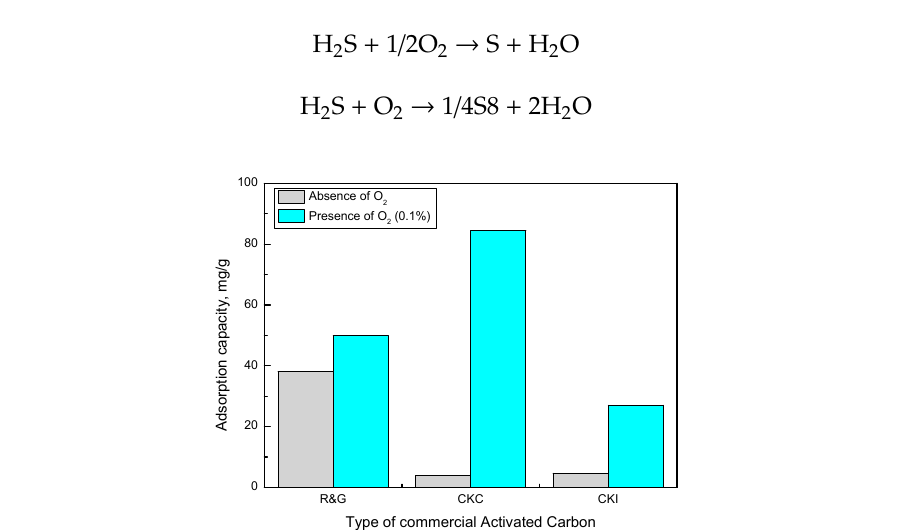
Table 3. Sorbent test results using several gas mixtures (adopted from [73]).